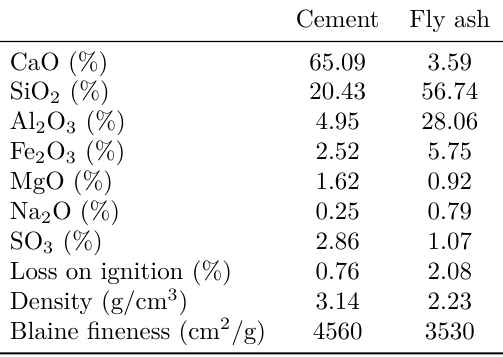
Table 1. Chemical compositions and physical properties of cement and fly ash.